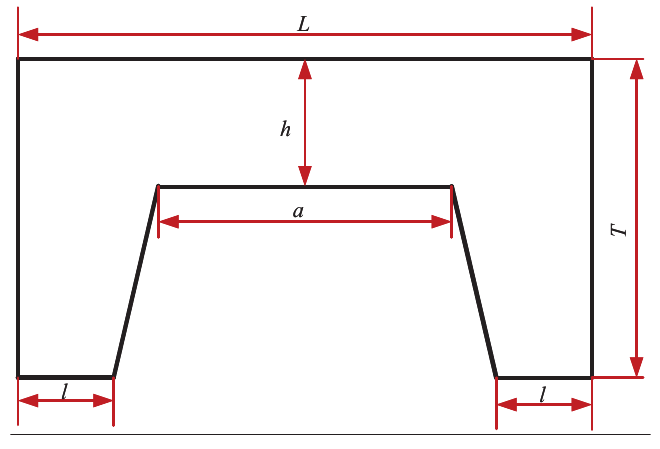
Figure 5. The side view diagram of the silicon